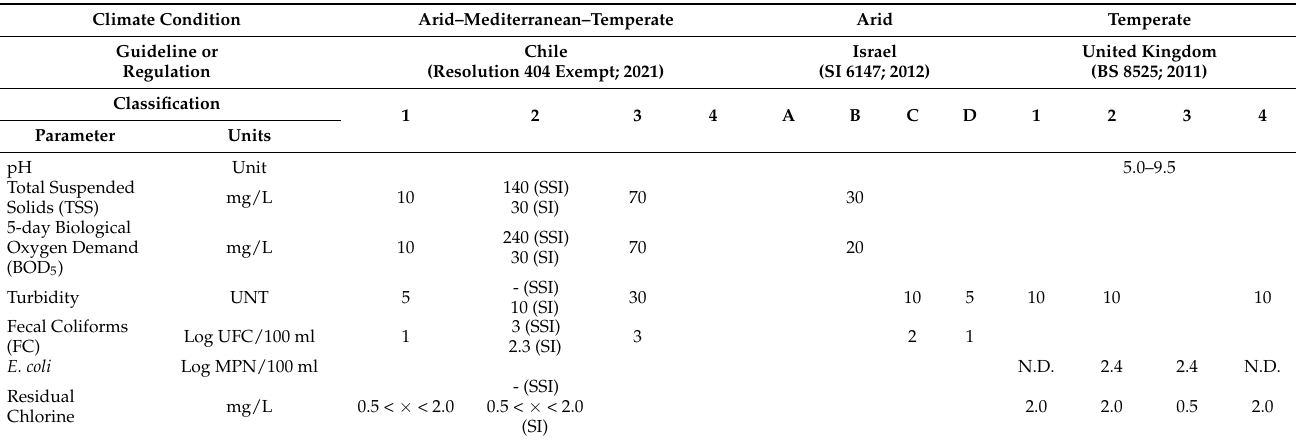
Table 4. Water quality standards proposed for greywater reuse, Resolution 404 Exempt, and compari- son with Israel and United Kingdom